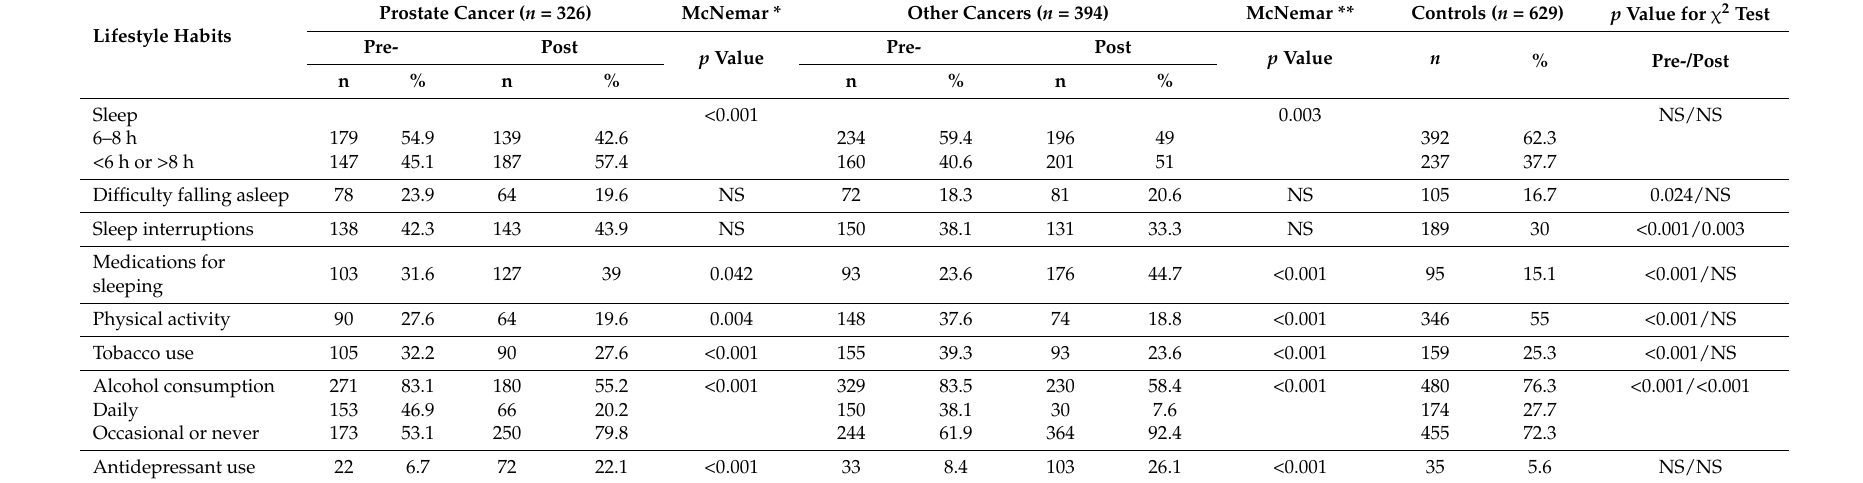
Table 3. Sleep, physical activity, and other lifestyle characteristics pre- and post-diagnosis of